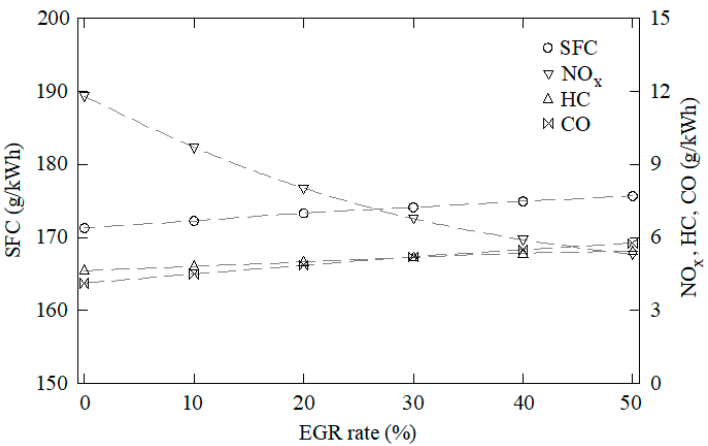
Figure 4. SFC, NO x , CO, and HC emissions against the EGR rate. Water to fuel ratio = 0, overlap timing = 96°, intake valves closing = 568°, cooling water temperature = 76 °C.